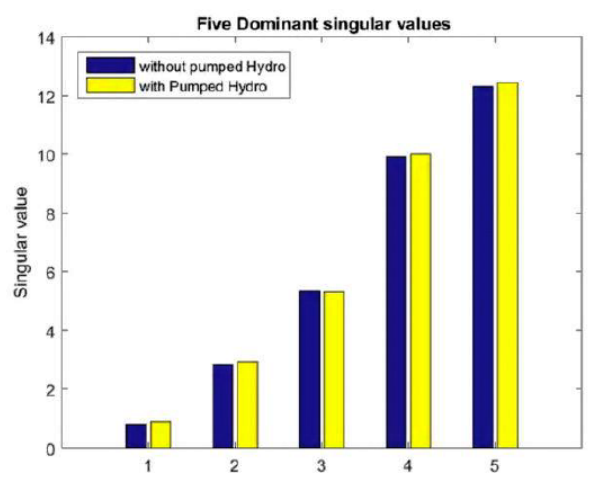
Figure 12. Result plot with and without PHG: Period